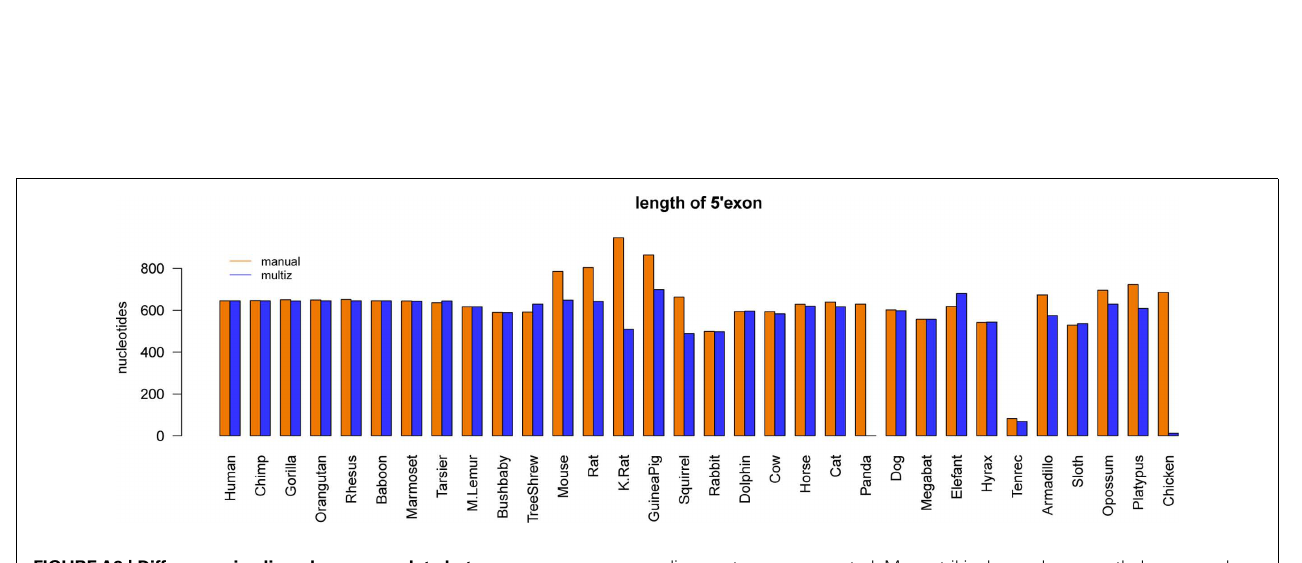
FIGUREA1 | Sequence conservation of EGO-B as indicated by the phastCons program. We have computed the phastCons scores for three different alignment approaches using the vertebrate model available at the UCSC Genome Browser: (1) our own muscle alignment, (2) the pre-computed 46-way vertebrate multiz alignment from the UCSC browser, and (3) a